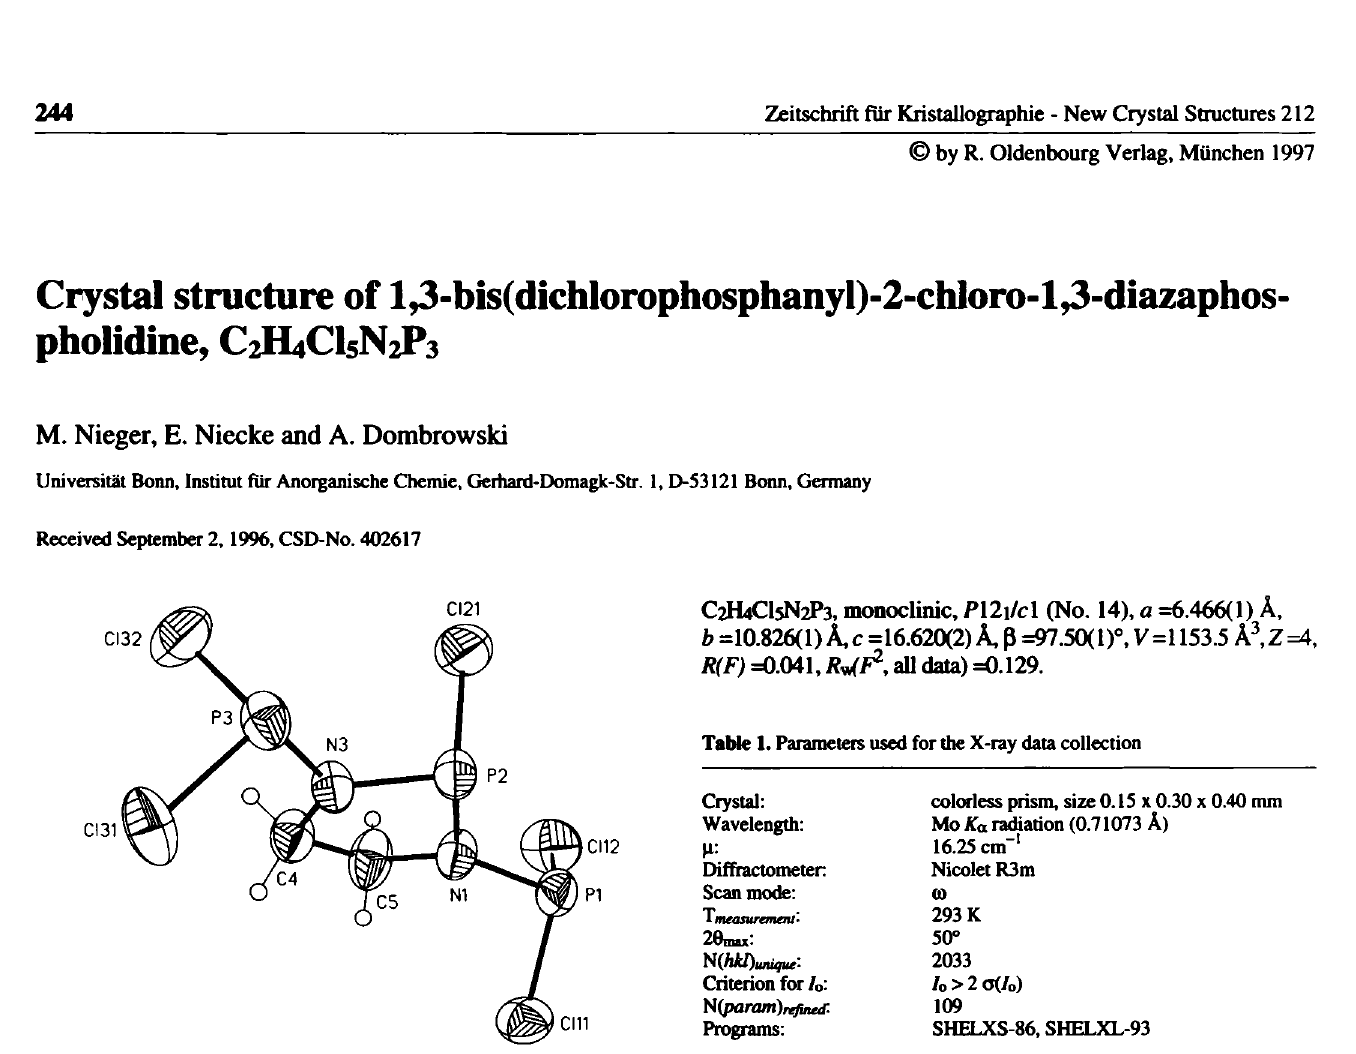
Table 2. Final atomic coordinates and displacement parameters (in Â 2